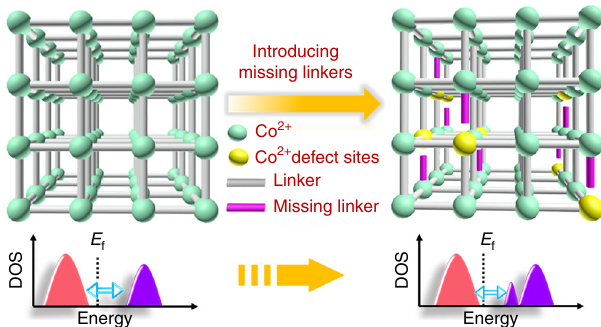
Fig. 1 Modulating electronic structure of MOFs via introducing